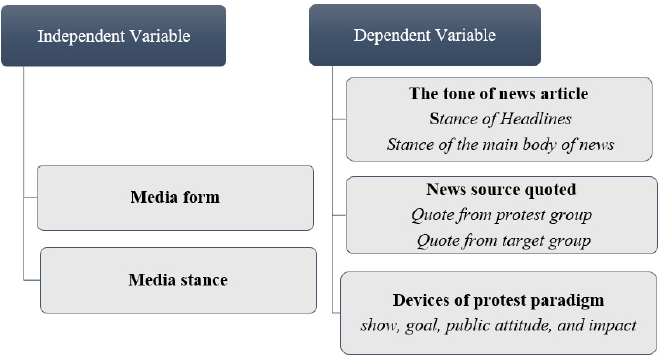
Figure 1. Measurement of independent variables and dependent variables. Table 1. The evaluation criteria for the four framing devices.